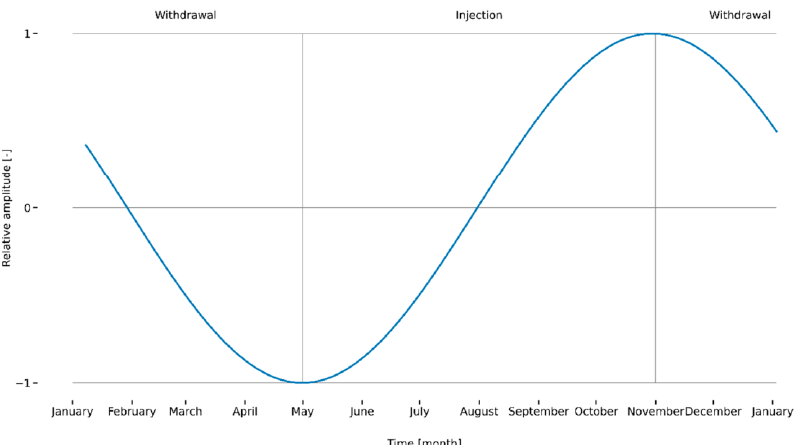
Figure 2. The theoretical course of the injection and withdrawal cycle at the UGS (taken from [ Er- ror! Reference source not found. ]).